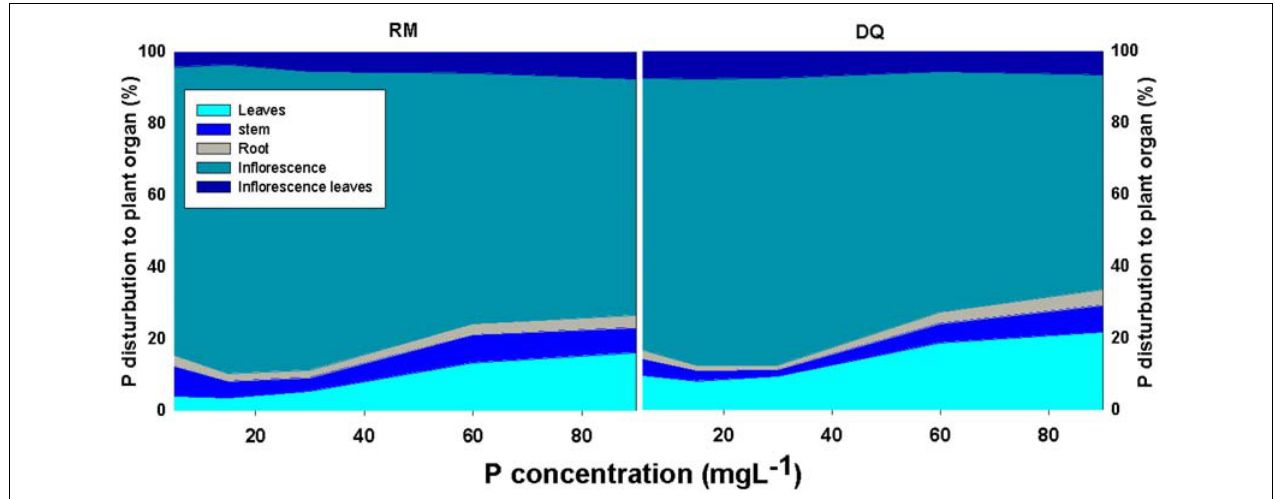
FIGURE 7 | Effect of P supply on the distribution of P in the plant to leaves, stem, roots, inflorescences, and inflorescence-leaves, in two medical cannabis cultivars, RM and DQ. The total P content in each organ is presented as the percent content of the total P in the plant. Presented data are averages ( n =